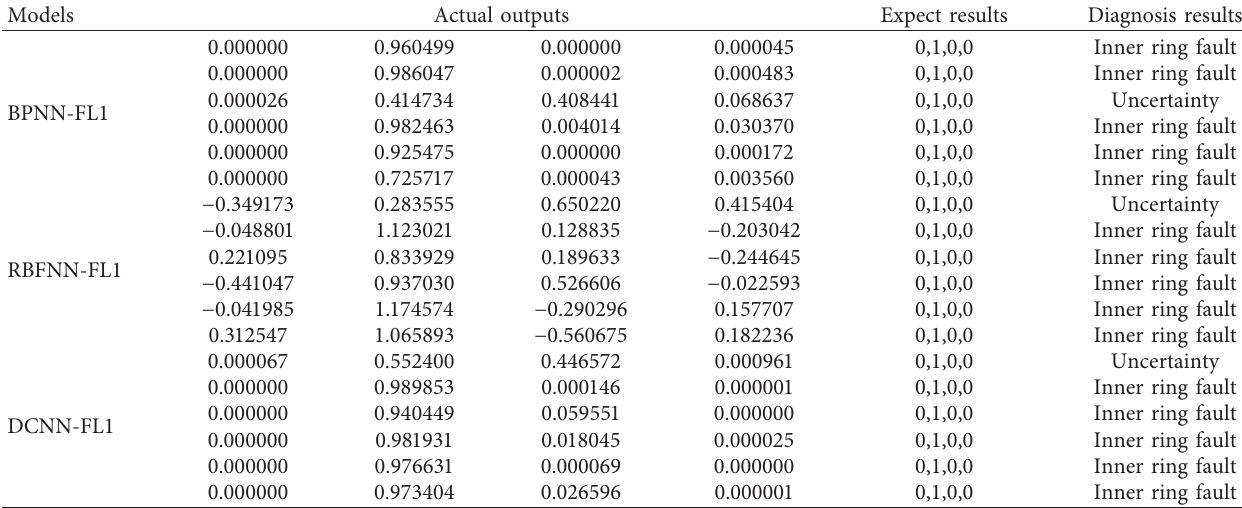
Table 6: The actual outputs of the three network models are compared with the expected results.